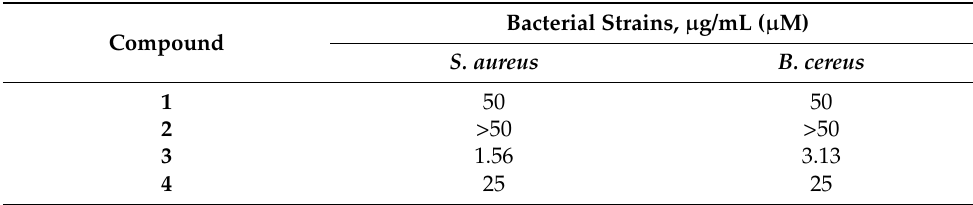
Table 5. In vitro antibacterial activity of amino-acid-modified flavone compounds. ( 1 )